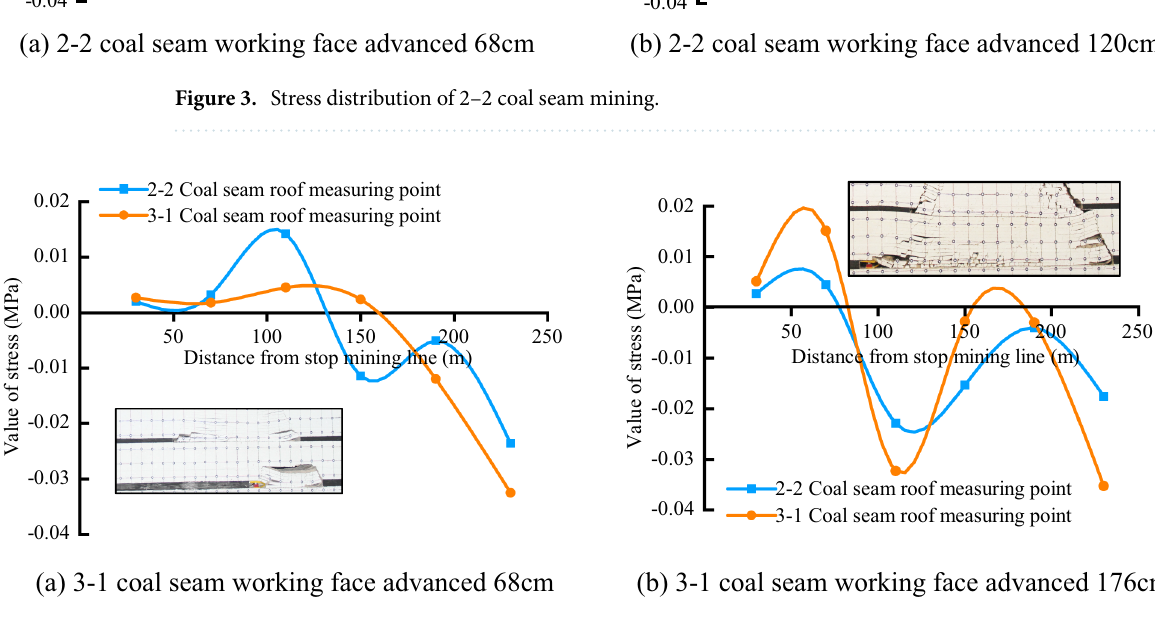
Figure 4. Stress distribution of 3-1 coal seam